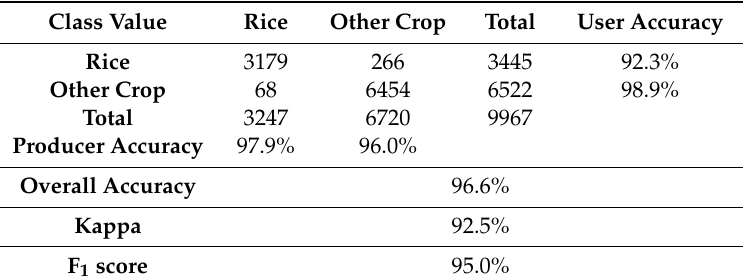
Table 3. Confusion matrix for the RF classifier. Table 3: Confusion matrix for the RF classifier